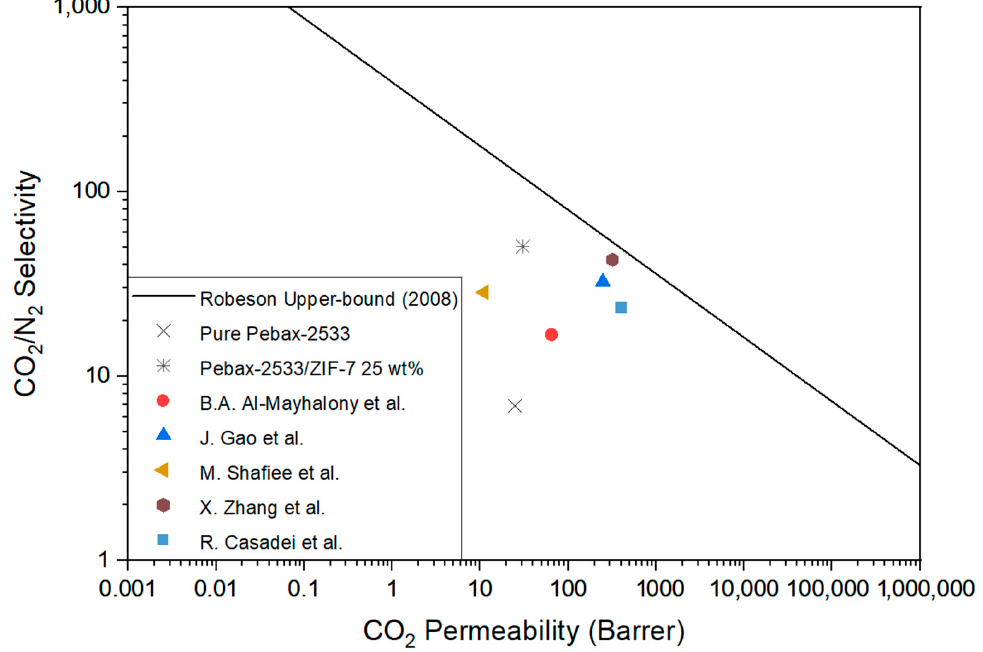
Figure 20. Gas permeation of pure Pebax-2533, Pebax-2533/ZIF-7 25 wt% composite membrane, and various membranes with Robeson upper bound.